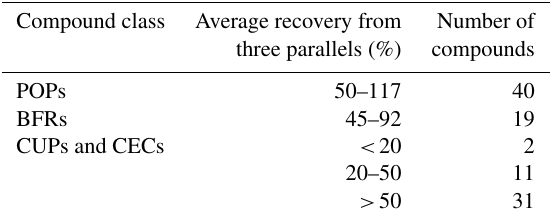
Table 2. Summary of average recovery rates (%) for legacy POPs, BFRs, CUPs and